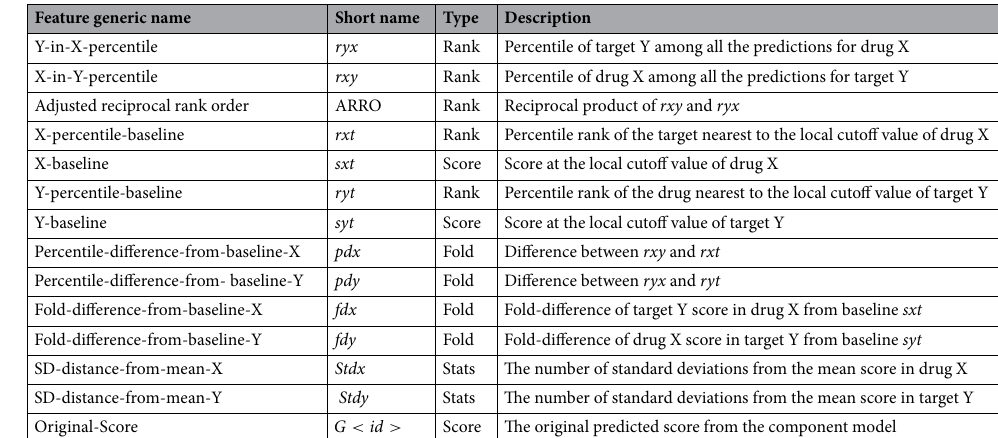
Table 2. The 14 RP features derived from DTI pair-specific one-to-all score curves.